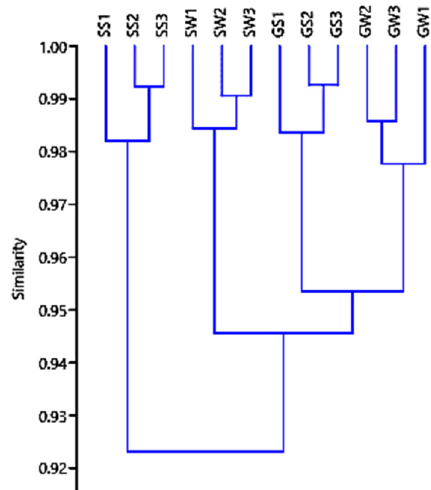
Figure 1. Hierarchical clustering of harvest seasons (spring vs. winter) using chemical composition and in vitro fermentation kinetic data of Paulownia shan tong.